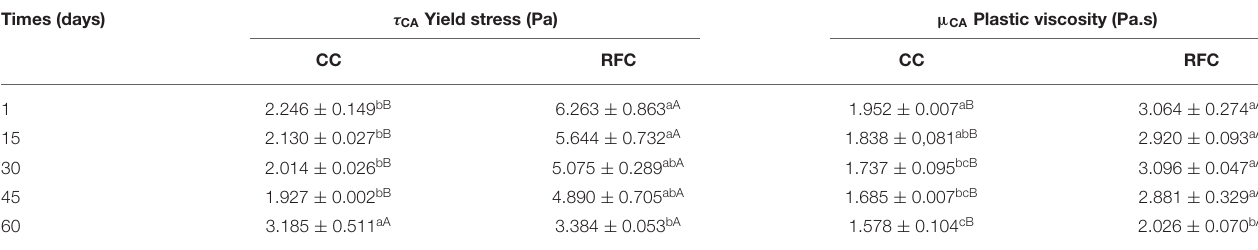
TABLE 3 | Yield stress ( τ CA) and plastic viscosity ( µ CA) of the control chocolate (CC) and reduced fat chocolate (RFC) obtained by the Casson model. Times